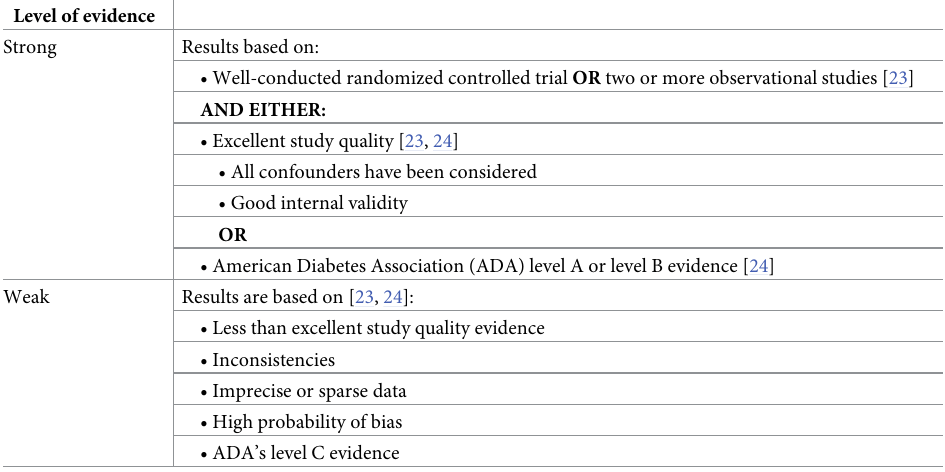
Table 1. Classification and quality of